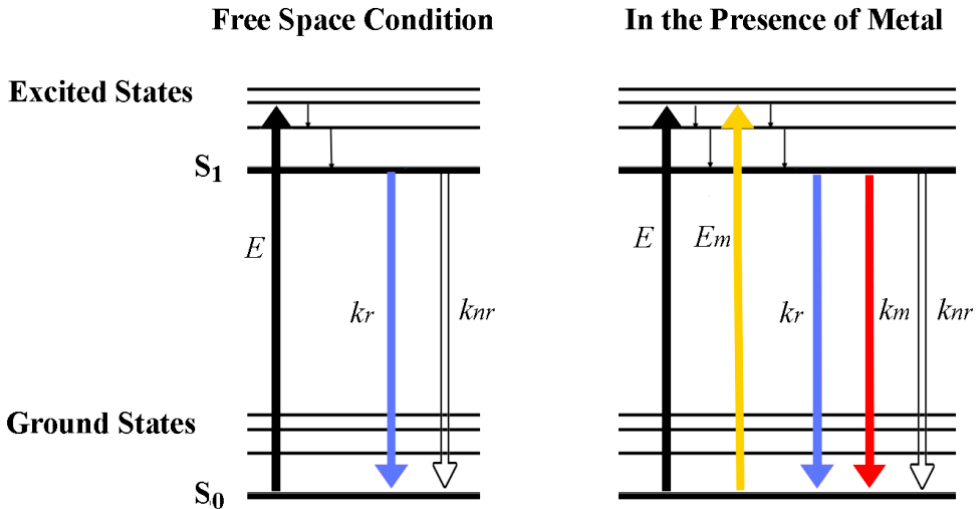
Figure 3. Schematics illustrating the excitation and emission processes of a fluorophore in the absence and vicinity of a metal. S 0 and S 1 represent the ground and excited electronic energy states, respectively. E denotes for the excitation energy whereas k r , k nr , and k m are rate constants associated with the different radiative and nonradiative emission processes.